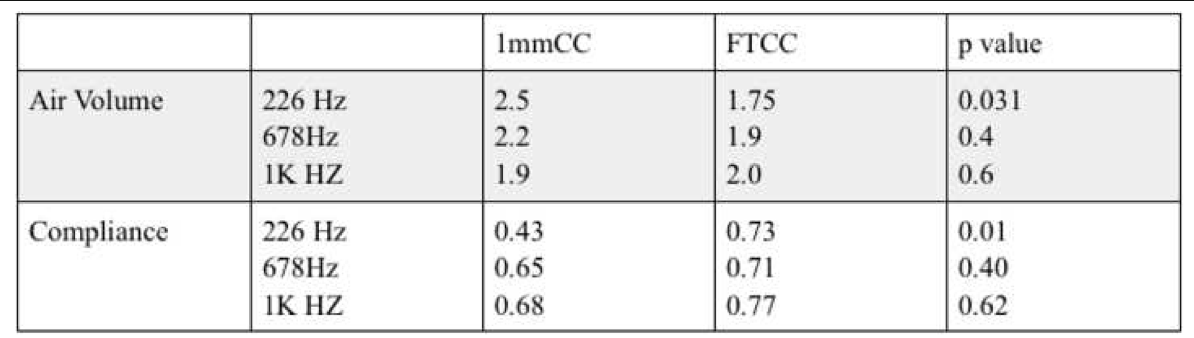
Table 2 Showing the difference in air volume and compliance between two